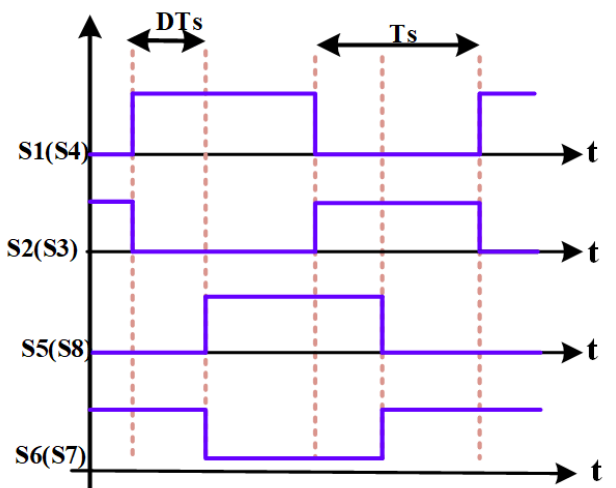
Figure 14. Single-Phase Shift control waveform for BWPT